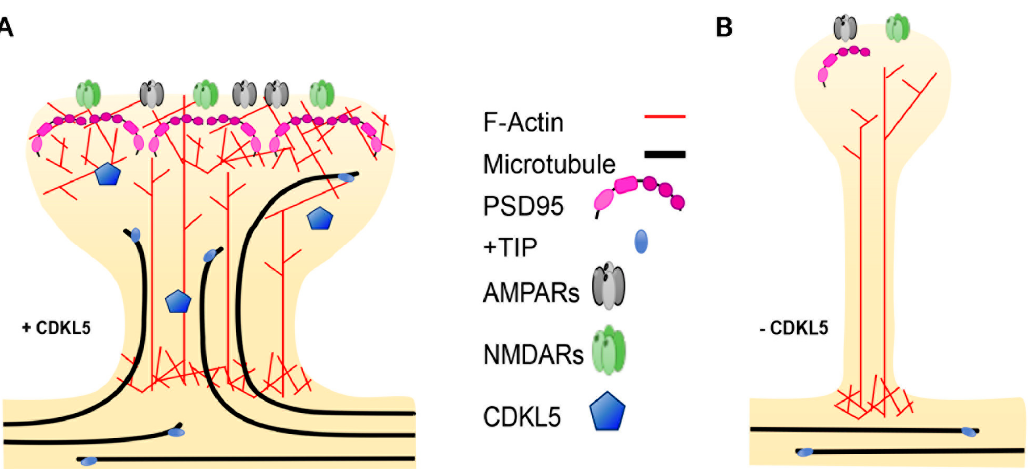
Figure 4. The effect of CDKL5 deficiency on dendritic spine morphology. ( A ) Dendritic spines, which are enriched in actin, are invaded by microtubules (MTs) upon neuronal activation. The plus-end tracking proteins ( + TIP), bound to the MT plus-ends, interact with actin-binding proteins facilitating the invasion. ( B ) In the absence of CDKL5, MTs are less dynamic and fail to invade the spines, impacting the activity-dependent structural changes that lead to the formation of mushroom-shaped